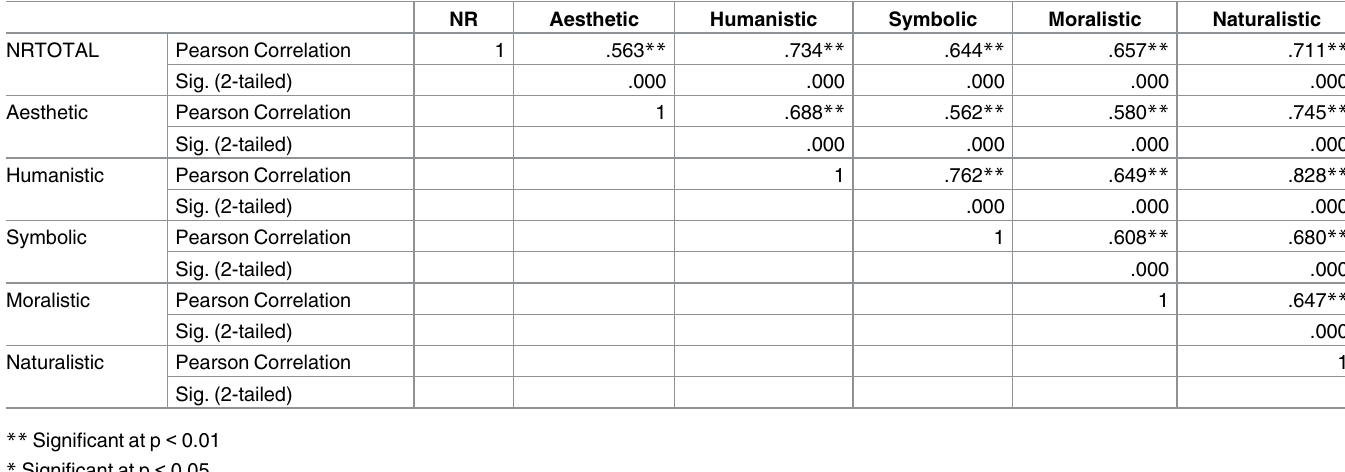
Table 11. Inter-Correlations between valuing being able to engage with the five biophilic values (N = 118).